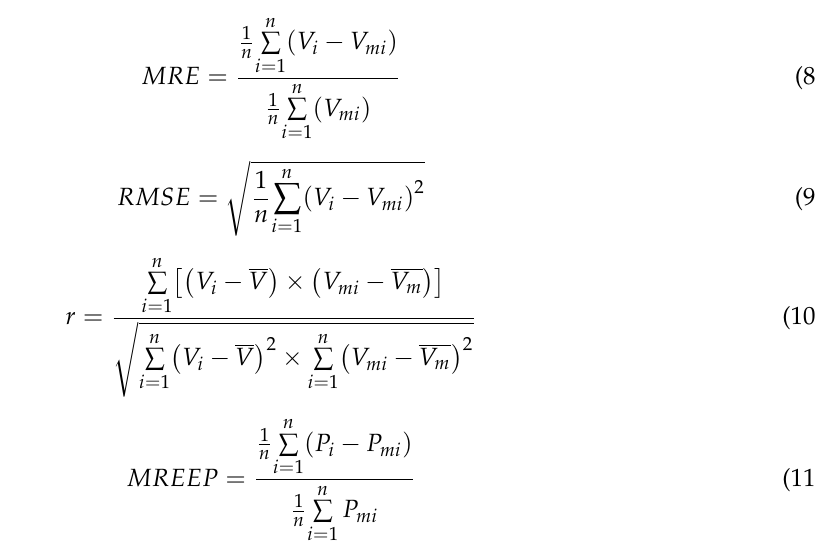
Figure 14. Output power curve of the wind turbine used in the case study.